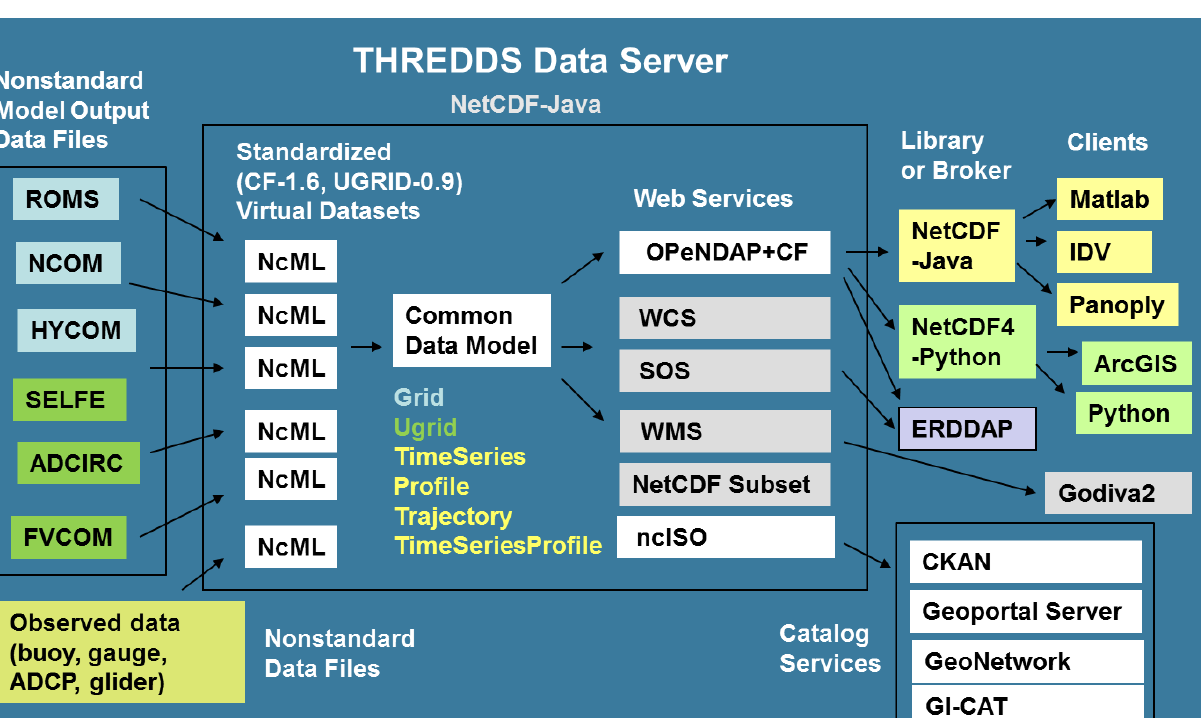
Figure 3. Schematic of the IOOS Coastal and Ocean Modeling Testbed (COMT)